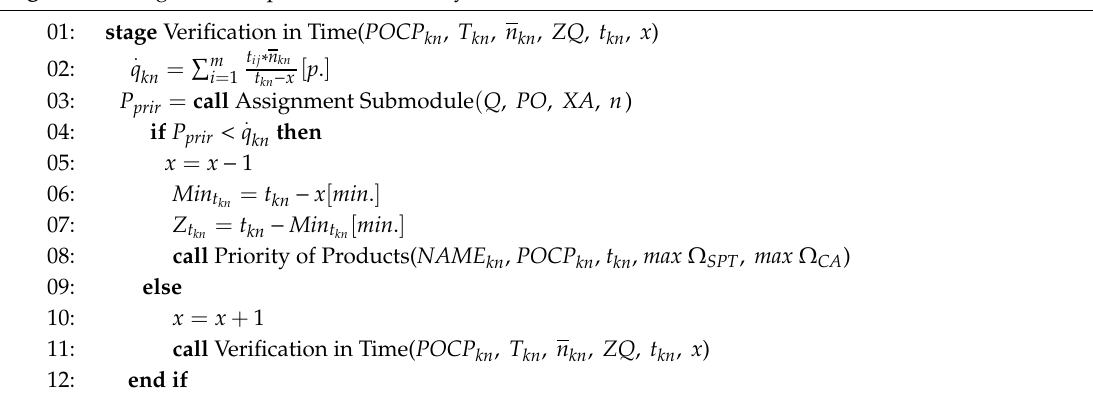
Algorithm 2 Algorithm of product verifiability in